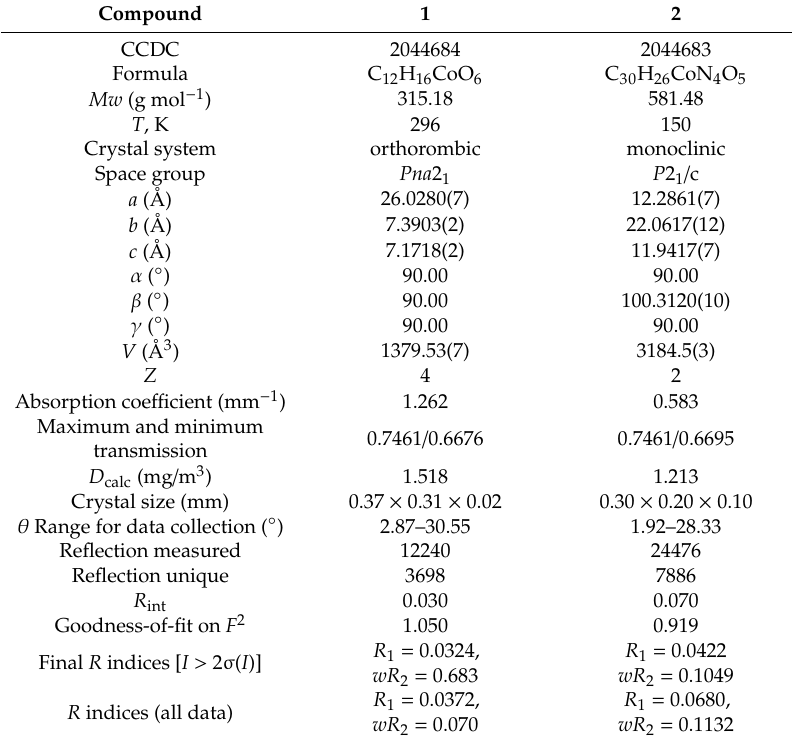
Table 1. Crystal data and structure refinement for 1 and